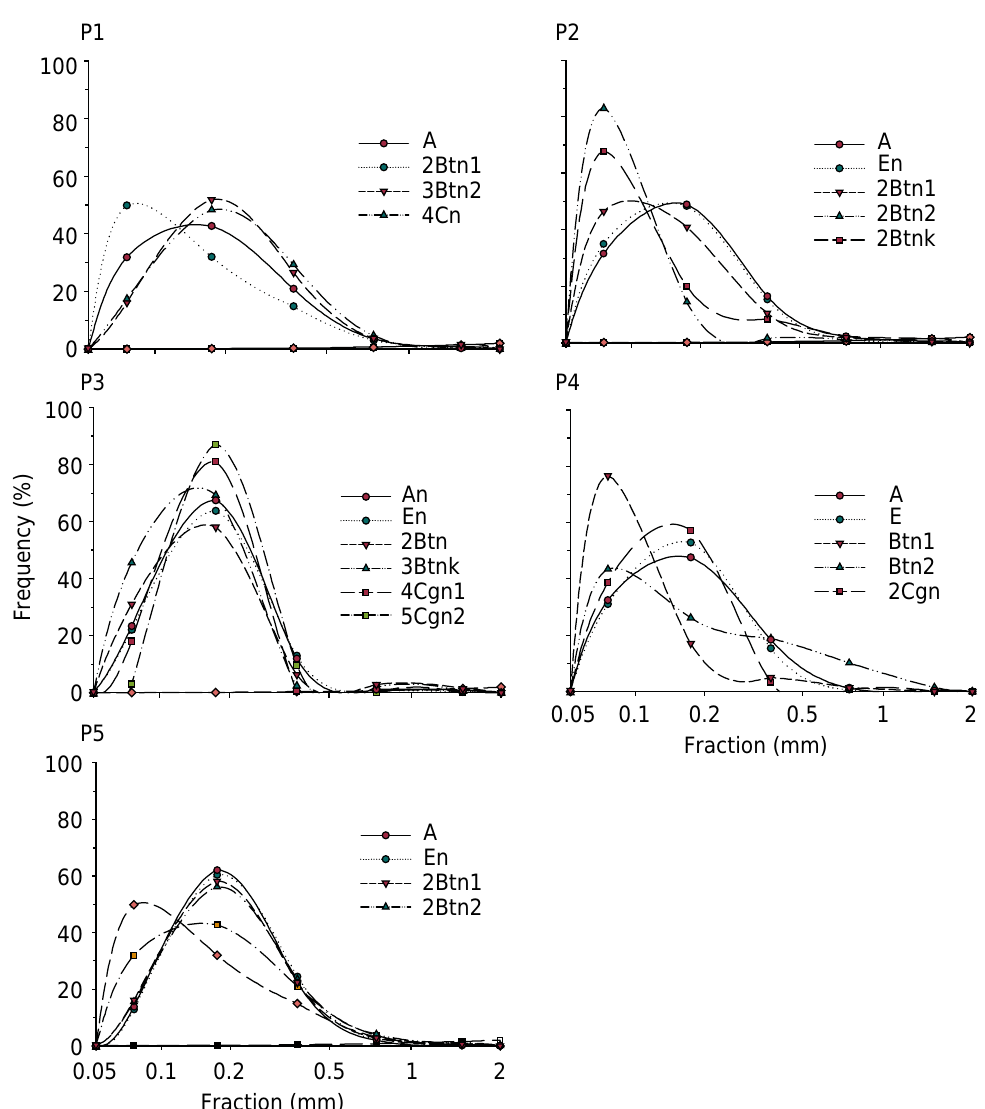
Figure 4. Relative distribution of the sand fractions (very fine, fine, medium, coarse, and very coarse) of each horizon in the